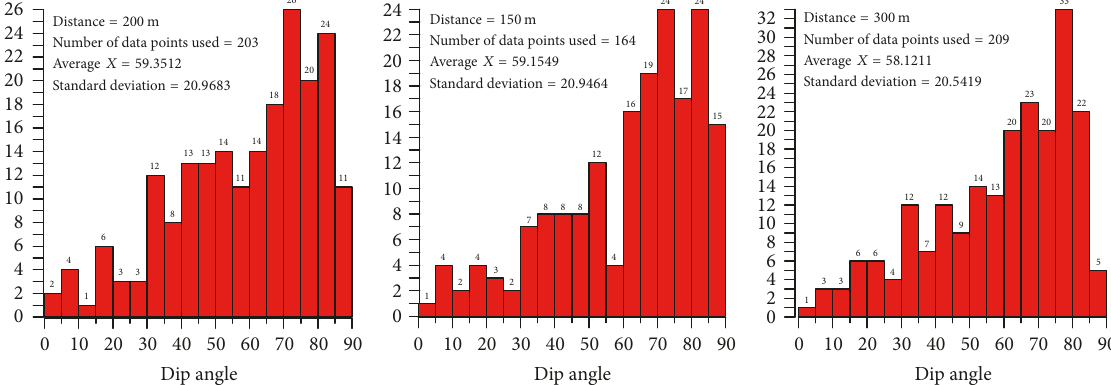
Figure 35: Histograms of the Frac-Digger sensitivity of the estimated dip angles of dikes to the distance from the event to the plane ( 𝛿𝑍 ).